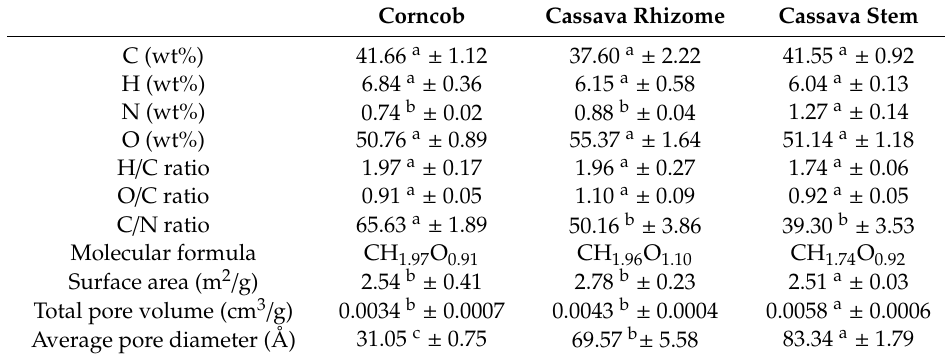
Table 1. Properties of biomass